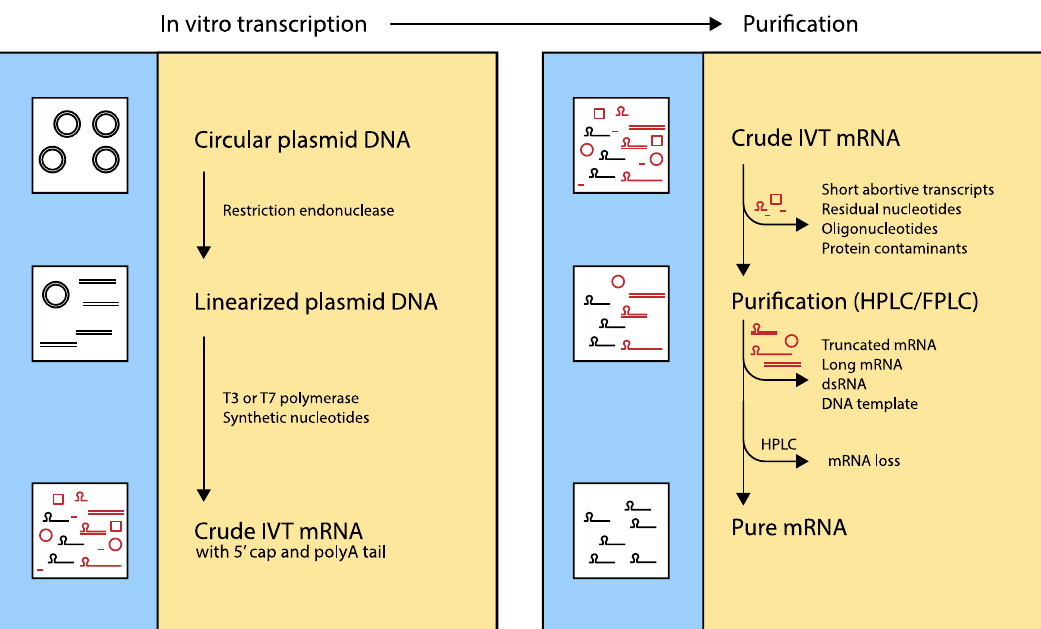
Fig. 2 IVT-mRNA transcription and puri fi cation. Crude IVT-mRNA which has been generated synthetically from a linearized DNA template using polymerases (T3/T7) often contains a mixture of the mRNA molecules with different categories of impurities. The crude mRNA is initially subjected to extraction and precipitation processes which remove some but not all the impurities, fi nal HPLC or FPLC treatment generates pure grade mRNA